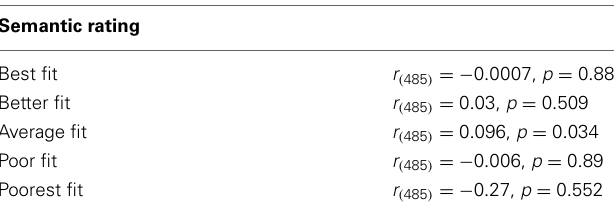
Table 3 | Pearson correlation between un-forms and their top two pre-emptors.